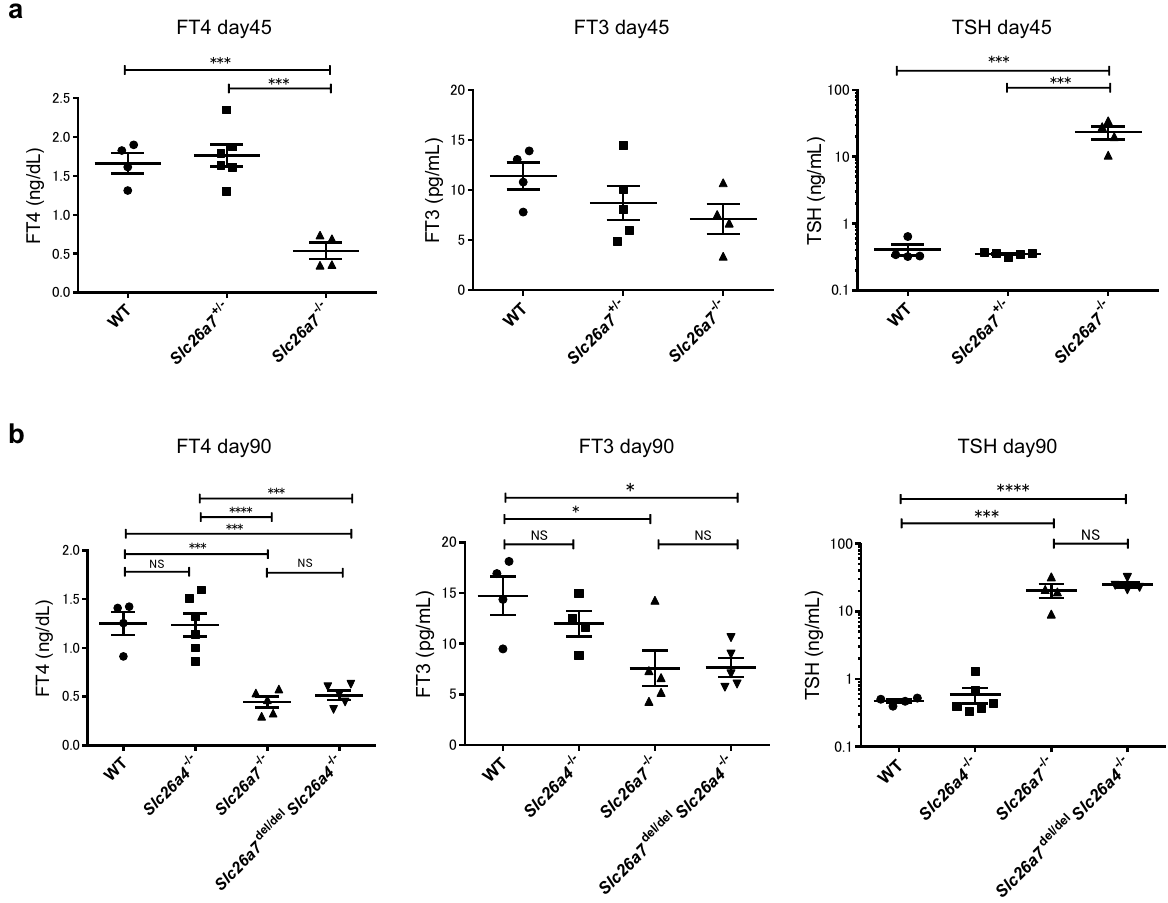
Figure 2. Serological phenotypes of the deficient mice. ( a ) Serum free thyroxine (FT4), free triiodothyronine (FT3), and thyrotropin (TSH) levels in male wild type (WT), Slc26a7 +/− , and Slc26a7 −/− mice at day 45; n = 4–7 mice of each genotype. One-way analysis of variance (ANOVA) showed significant differences in FT4 and TSH levels (FT4: F (2, 11) = 23.4, p = 0.0001; TSH: F (2, 10) = 22.5, p = 0.0002), but not in FT3 levels ( F (2, 10) = 1.76, p = 0.219). *** p < 0.001 determined by Tukey’s test. ( b ) Serum FT4, FT3, and TSH levels in male WT, Slc26a4 −/− , Slc26a7 −/− , and Slc26a7 del/del Slc26a4 −/− mice at day 90; n = 4–6 mice of each genotype. One-way ANOVA showed significant differences in FT4, FT3, and TSH levels (FT4: F (3, 16) = 22.5, p < 0.0001; FT3: F (3, 14) = 5.29, p = 0.120; TSH: F (3, 14) = 30.3, p < 0.0001). * p < 0.05, *** p < 0.001, **** p < 0.0001 determined by Tukey’s test. FT4 free thyroxine, FT3 free triiodothyronine, TSH thyrotropin, WT wild